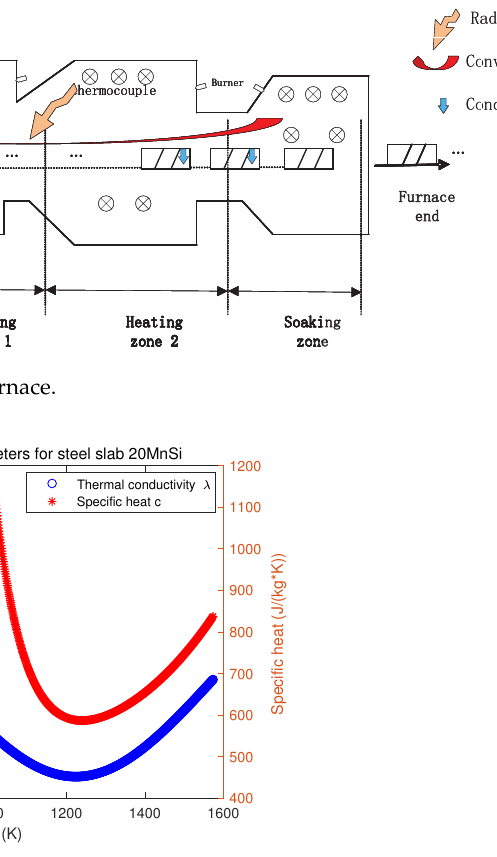
Figure 2. Temperature dependent material parameters for steel slab